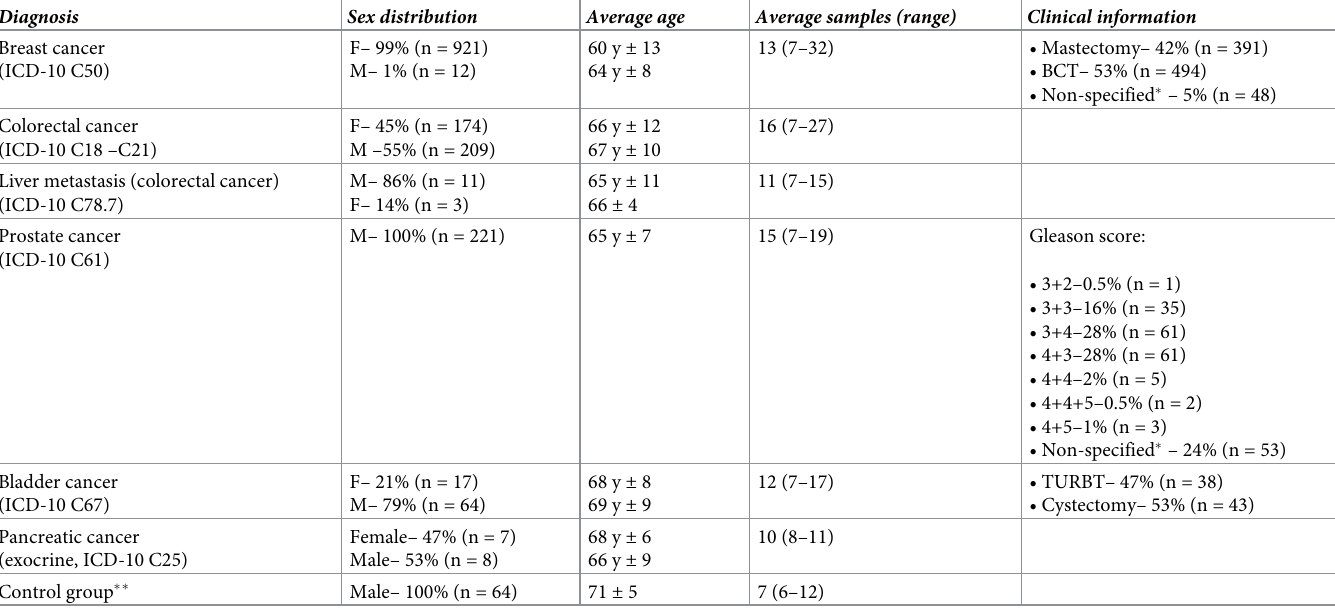
Table 2. A summary of donors and cancer diagnoses included in the collection (status as of May 12, 2021). Diagnosis Sex distribution Average age Average samples (range) Clinical information Breast cancer (ICD-10